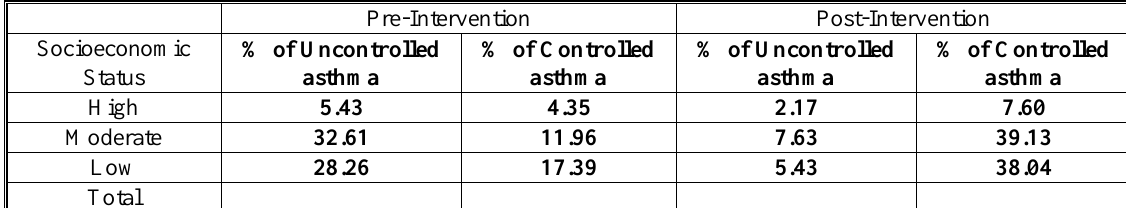
Table 3. The descriptive characteristics of asthma control and socioeconomic